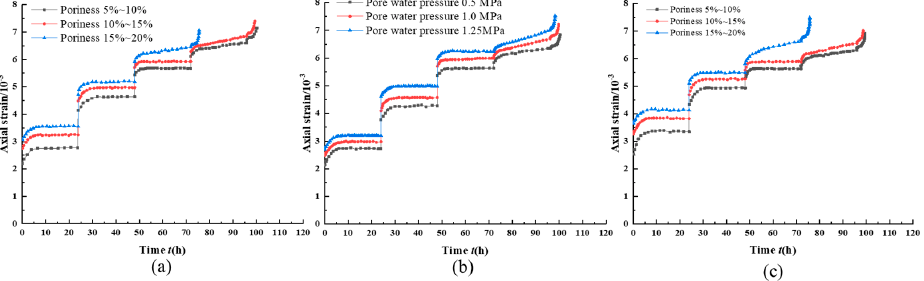
Figure 9. Creep deformation curves under different conditions. ( a ) Deformation curves of different porosity without water pressure; ( b ) Porosity deformation curve of different pore water pressure; ( c ) Deformation curves of different porosity under pore water